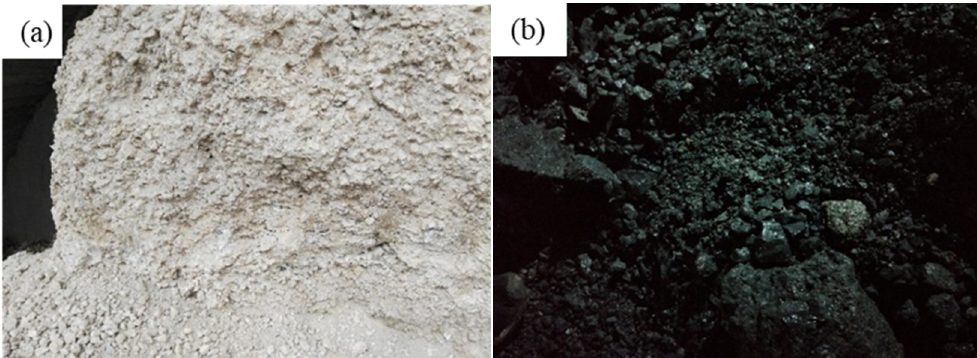
Figure 4. The deformation characteristics of surrounding rock in Xujiadi tunnel: ( a ) Before water-softening; ( b ) After water-softening.